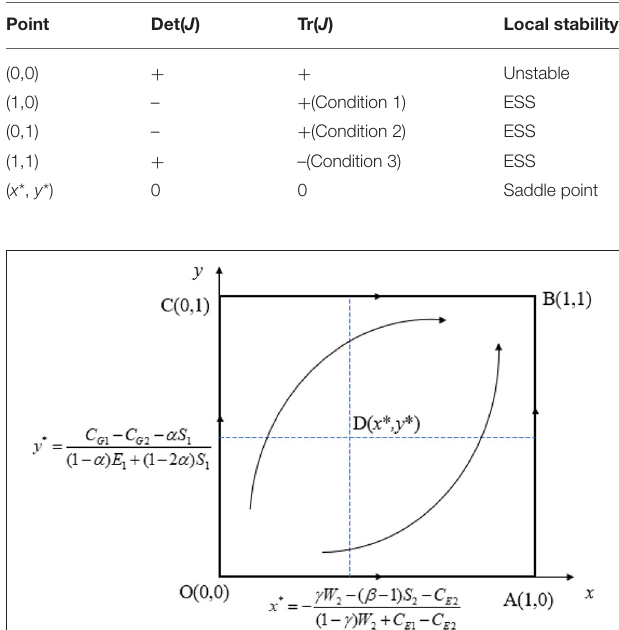
( x ∗ , y ∗ ) is a saddle point. Figure 5 shows the evolution of the system stable